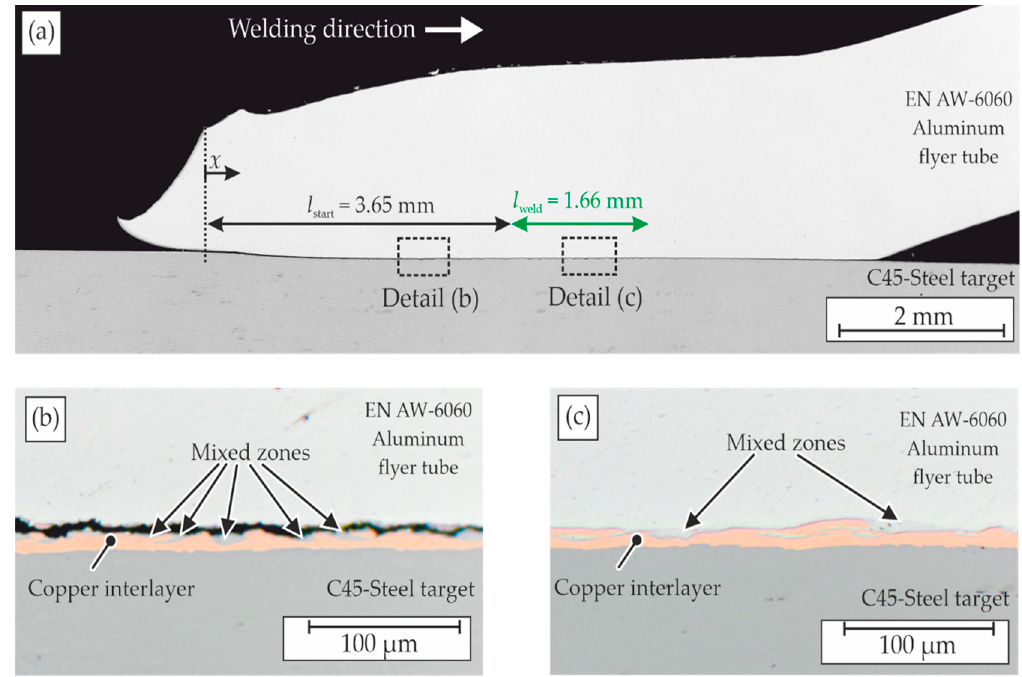
Figure 6. Cross sections of the MPW sample with E = 8 kJ and copper interlayer: ( a ) overview; ( b ) separated zone; and ( c ) welded zone.